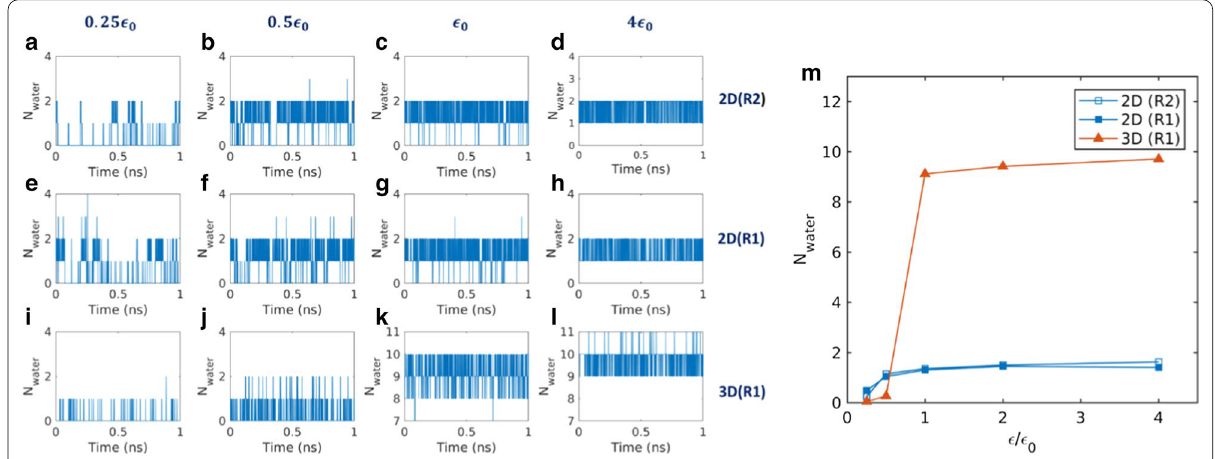
Fig. 4 Water occupation number inside the nanopore for a – h 2D and i – l 3D membranes. The membrane–water interaction strengths are 0.25 ǫ 0 for a , e , and i , 0.5 ǫ 0 for b , f , and j , ǫ 0 for c , g , and k , and 4 ǫ 0 for d , h , and l . Average occupation numbers vary with the interaction strength ( m